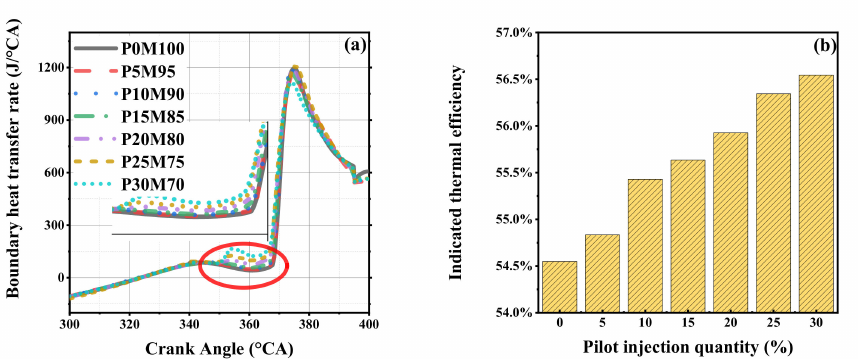
Figure 16. ( a ) Boundary heat transfer rate curves of different pilot injection mass ratios, positive values represented that the heat flow was towards boundary ( b ) Indicated thermal efficiency of different pilot injection mass ratios.